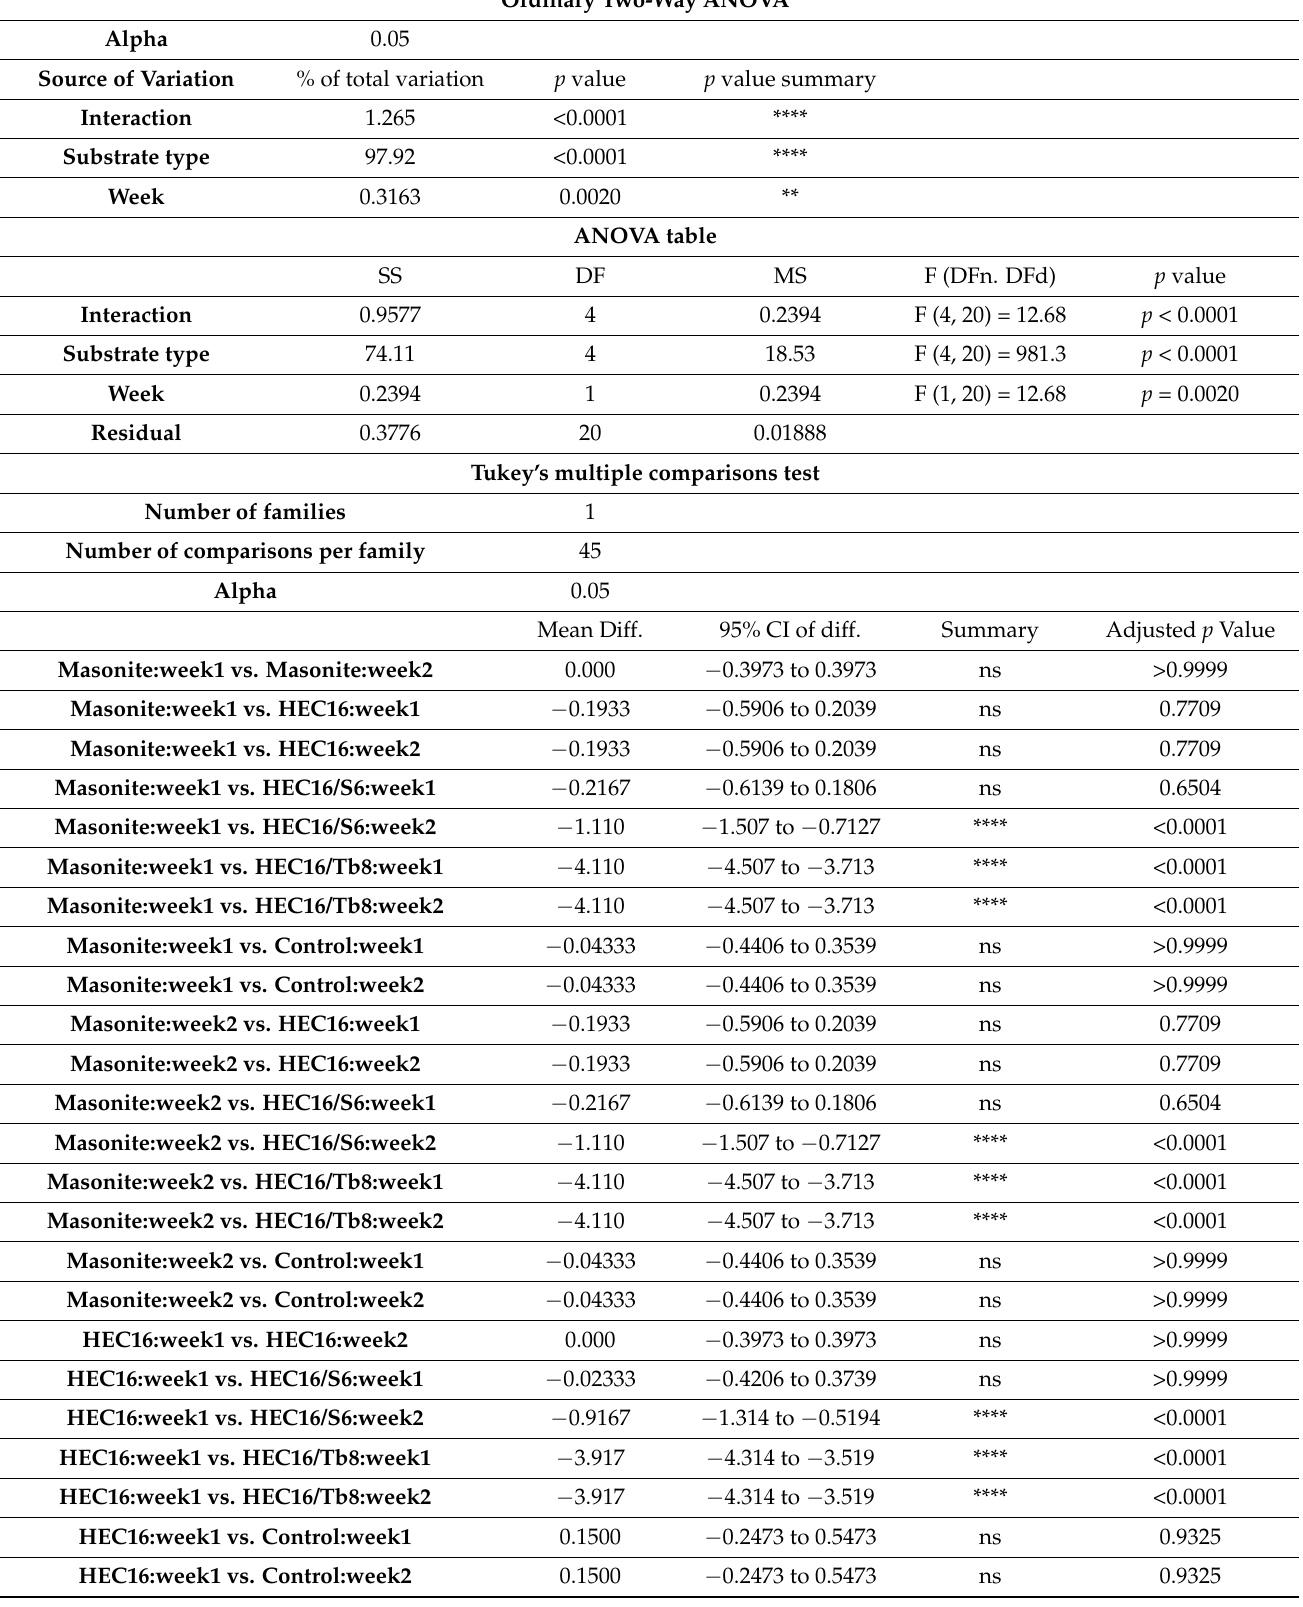
Table A9. Two-way ANOVA analysis and post-hoc Tuckey’s multiple comparison to evaluate the effect of time and oviposition substrates on T/C. p > 0.0123 = not significant (ns); p < 0.0021 **; p < 0.0001 =